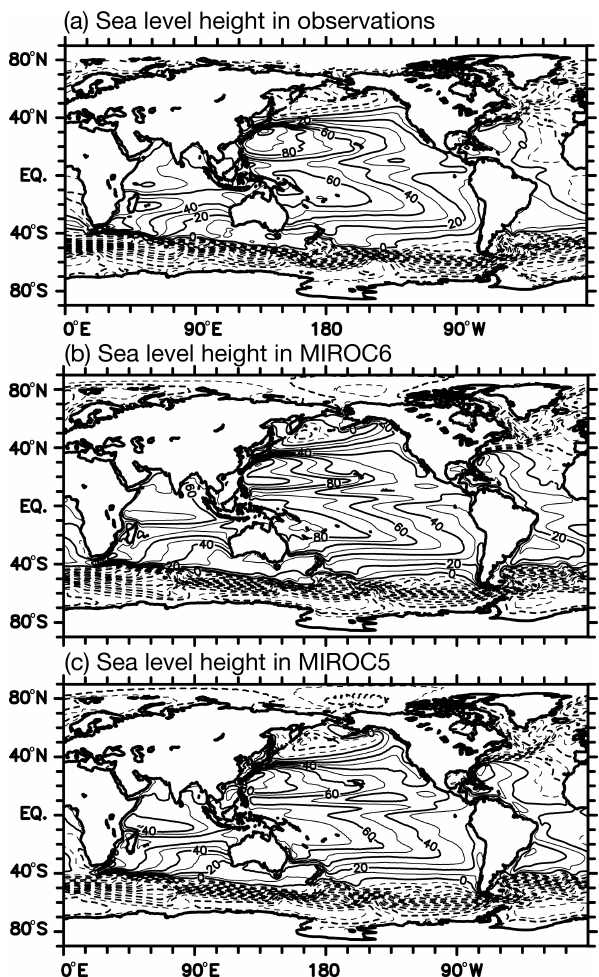
Figure 18. Annual mean sea level height relative to the geoid in (a) observations, (b) MIROC6, and (c) MIROC5. Contour interval is 20cm. Negative values are denoted by dashed lines. Note that loading due to sea ice and accumulated snow on sea ice are removed from the model sea level height and that the global mean value is